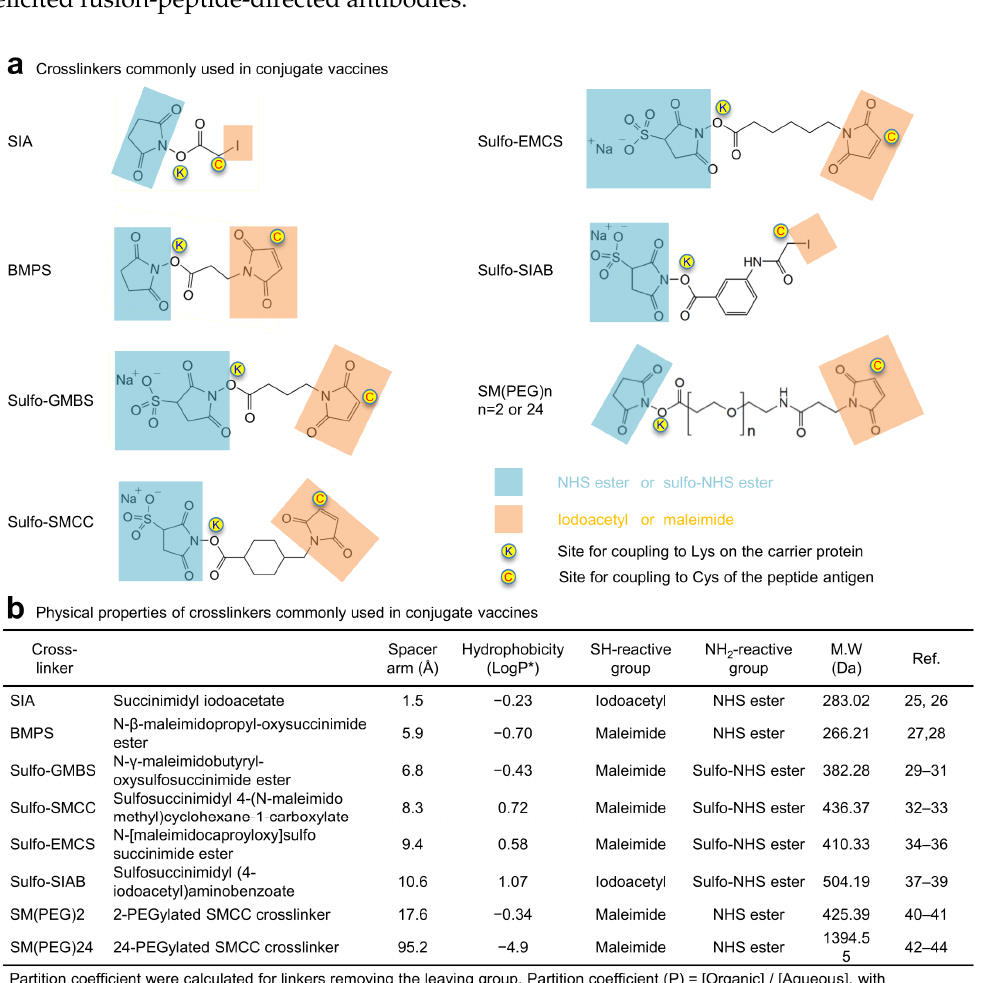
Figure 1. Chemistry of crosslinkers used to conjugate FP8v1 to carrier proteins. ( a ) Structures of crosslinkers used for the conjugation. Functional groups reactive to amino and sulfhydryl groups are highlighted in light blue and orange, respectively. ( b ) Physical properties of crosslinkers commonly used in biomolecule conjugates. All eight crosslinkers, including succinimidyl iodoacetate (SIA) [25,26], N- β -malei- midopropyl-oxysuccinimide ester (BMPS) [27,28], GMBS [29–31], SMCC [29,32,33], N- ε - malemidocaproyl-oxysuccinimide ester (EMCS) [34–36], SIAB [37–39], 2-PEGylated SMCC (SM(PEG)2) [40,41], and 24-PEGylated SMCC (SM(PEG)24) [42–44], successfully crosslinked FP8v1 to the recombinant heavy chain of tetanus toxin (rTTHC), with the con- jugate products running on SDS-PAGE with molecular sizes larger than rTTHC and with various degrees of multimerization and stoichiometry (Figure 2a,b). The stoichiometry of FP8 conjugated to each rTTHC was around 10 for most of the conjugates, though lower (6.7) for the Sulfo-SIAB-crosslinked product and lowest (3.1) for the SIA-crosslinked prod- uct [45]. The Sulfo-SIAB-crosslinked product exhibited the most multimerization com- pared to the other crosslinkers, though size exclusion chromatography revealed a diverse range of sizes for the conjugated products (Figure 2b).